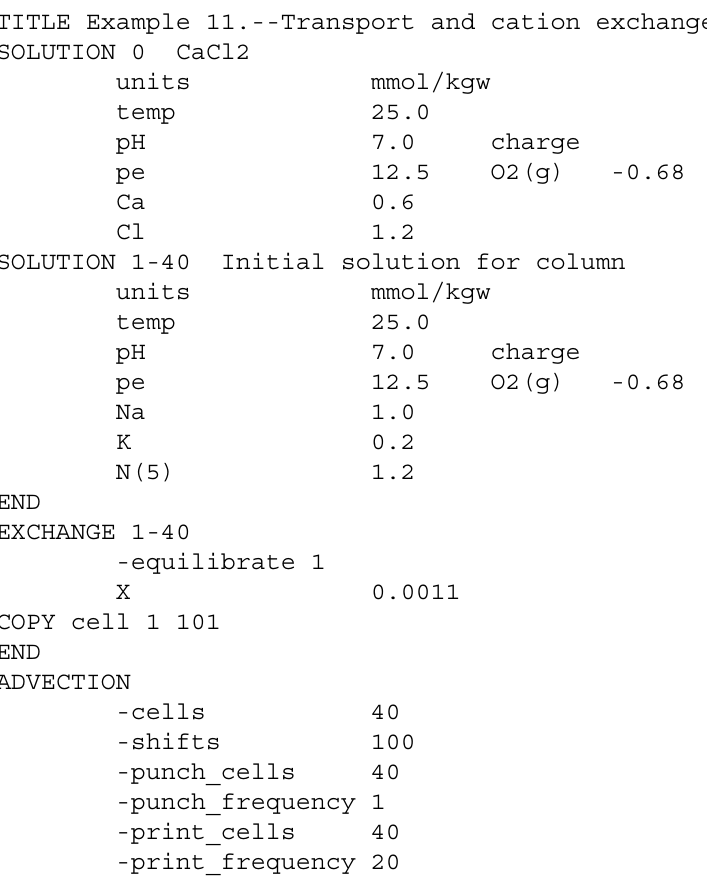
Table 30. Input file for example